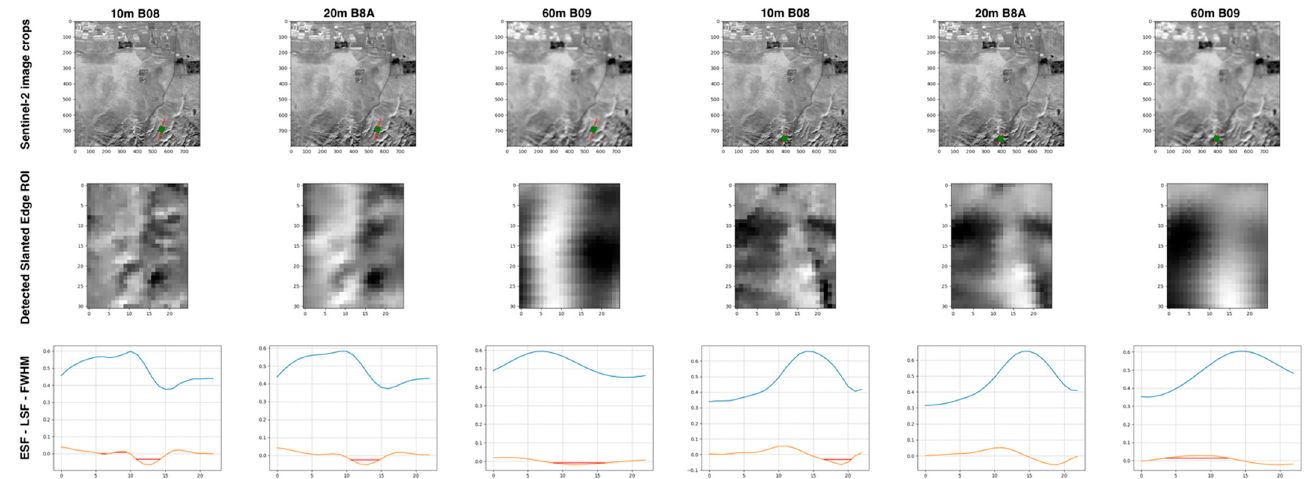
Figure 6. Examples of the Exp-2 ELF measurements for two detected slanted edge ROIs of a 8𝑘𝑚 × 8𝑘𝑚 image crop at Site-1. 1 st row: Sentinel-2 image crops of the 10m/pixel B08 band, 20m/pixel B8A band, and 60m/pixel B09 band images, showing two examples of the detected slanted edges in green box; 2 nd row: zoom-in views of the examplar slanted edges within the automatically extracted ROIs; 3 rd row: plots of ESFs (blue curve), LSFs (orange curve) and FWHMs (red line) for the examplar slanted edges. For all Exp-2 ELF measurements of all detected slanted edges within the 8𝑘𝑚 × 8𝑘𝑚 image crop at Site-1, please refer to supplementary material. N.B. Units of the x and y axes of the 1 st row and the 2 nd row, and x axes of the 3 rd row figures are “pixels”; units of the y axes of the 3 rd row figures are normalised intensity values – [0, 1] for ESF and [ − 0.1, 0.1] for LSF. 1 st and 2 nd rows show images at different sizes of 8𝑘𝑚 × 8𝑘𝑚 and 250𝑚 × 300𝑚 , respectively.